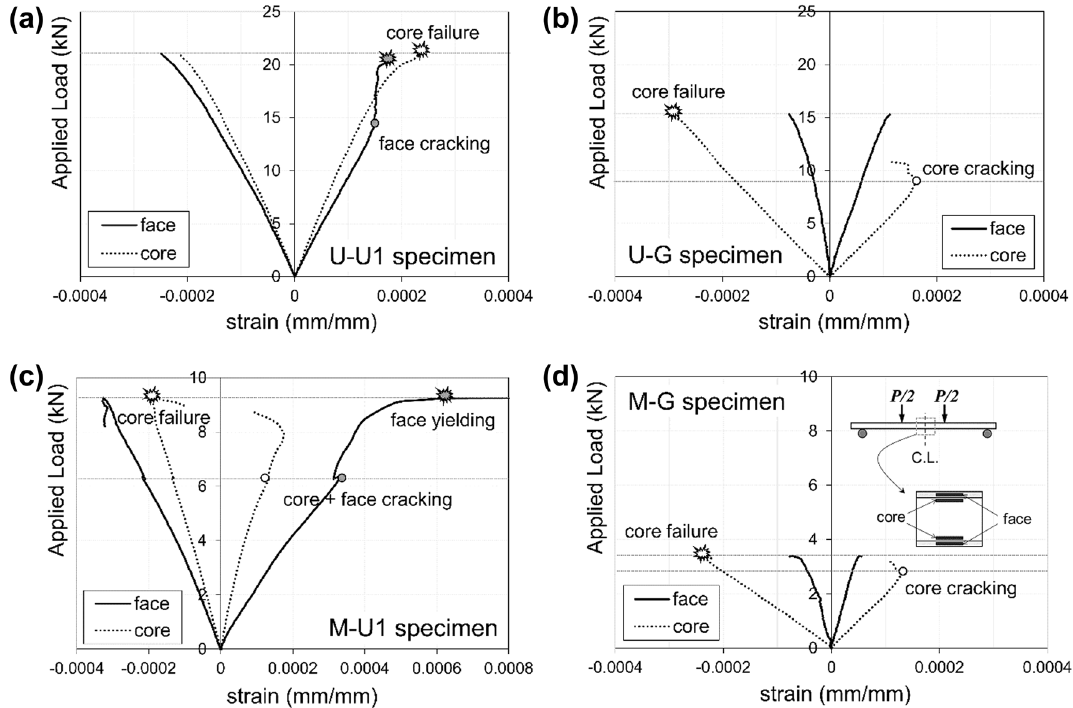
Fig. 12 Measured strain values of composite sandwich panels; a U-U1 specimen, b U-G specimen, c M-U1 specimen, and d M-G